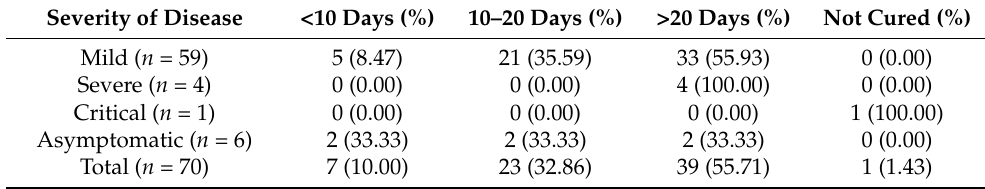
Table 3. Treatment time for infected students.